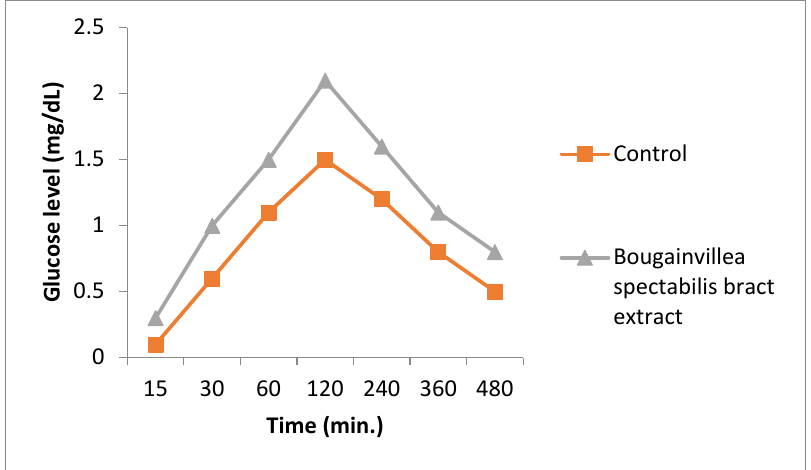
Figure 4. Glucose level (mg/dL) of herb extract.